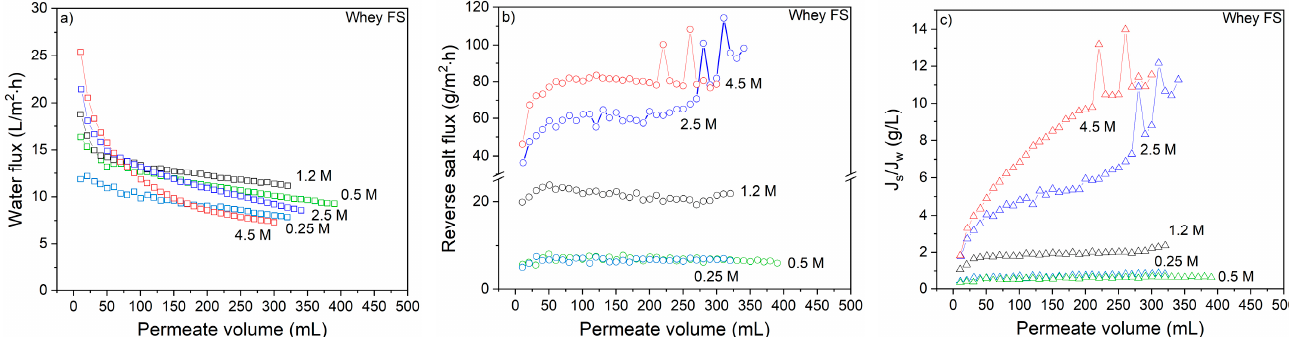
Figure 2. Slopes of the water flux vs. osmotic pressure difference between bulk DS and FS at each DS concentrations. FS: UPW.